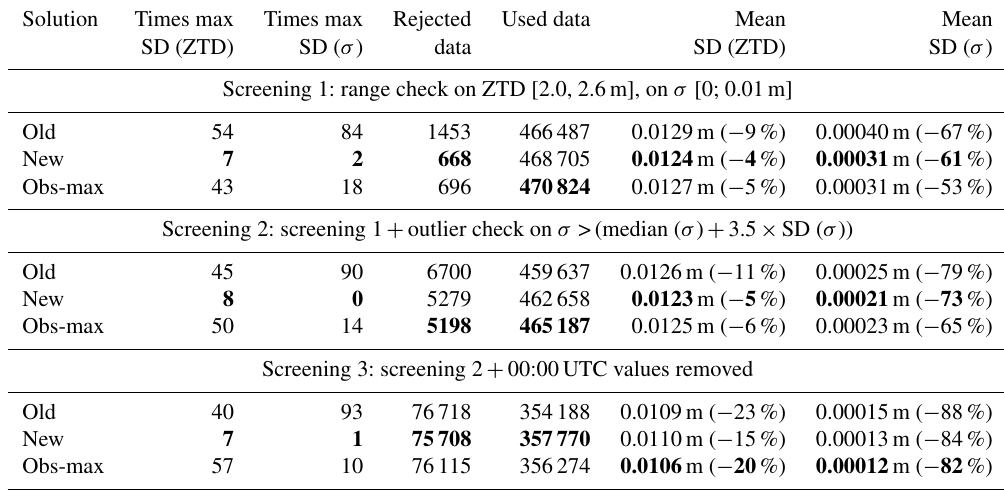
Figure 10. (a) ZTD and formal error of ZTD time series for station GDAN: new (red lines) and obs-max (green lines) baseline strategies. (b) Spikes in obs-max solution on days 170–171 are avoided in the new solution. Table 4. Similar to Table 2 but for other screening variants. The numbers in brackets in columns 6 and 7 indicate relative difference with the results of the “light screening” (values given in Table